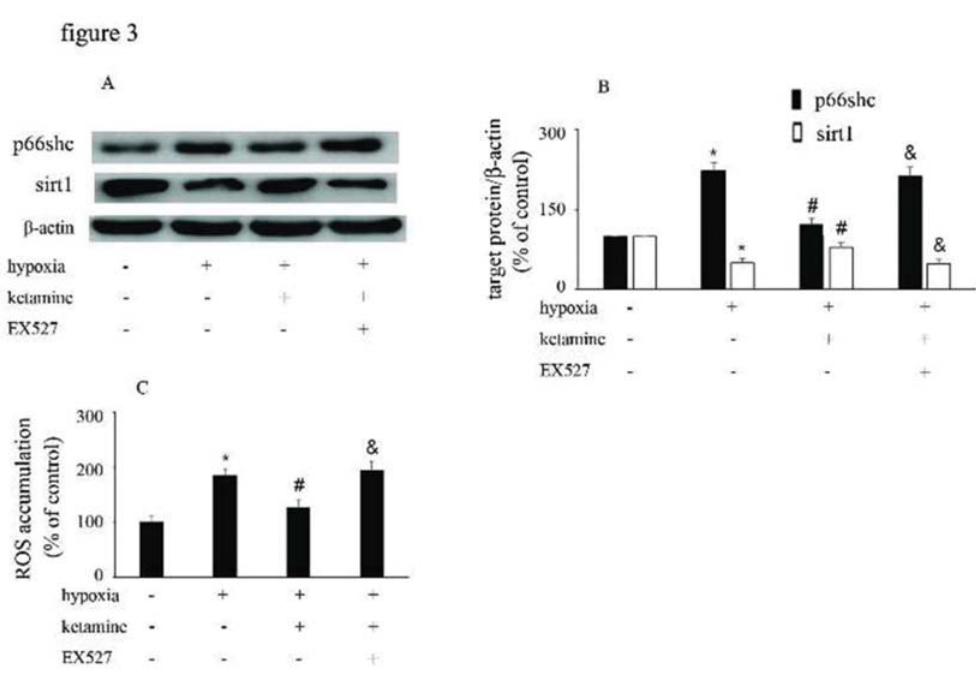
Figure 3 - p66Shc and sirt1 expression and ROS accumulation were altered by hypoxia, ketamine, and EX527 in HUVECs. (A) Equal amounts of proteins from HUVECs following the corresponding treatments were separated by SDS-PAGE and immunoblotted with antibodies against p66Shc and sirt1. (B) The ratio of the protein expression of each specific protein (p66Shc and sirt1) to the expression of b -actin. (C) ROS accumulation in HUVECs following the corresponding treatments (* p o 0.05 versus the control group, # p o 0.05 versus the hypoxia group, & p o 0.05 versus the ketamine group, n=5).